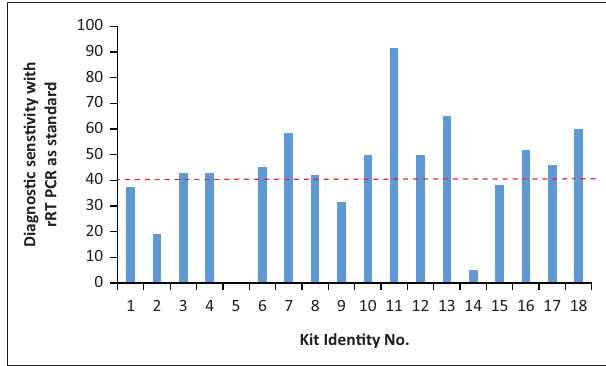
FIGURE 1: Diagnostic sensitivity of the pre-assessed COVID-19 point-of-care tests submitted to the Kenya Medical Research Institute by the Pharmacy and